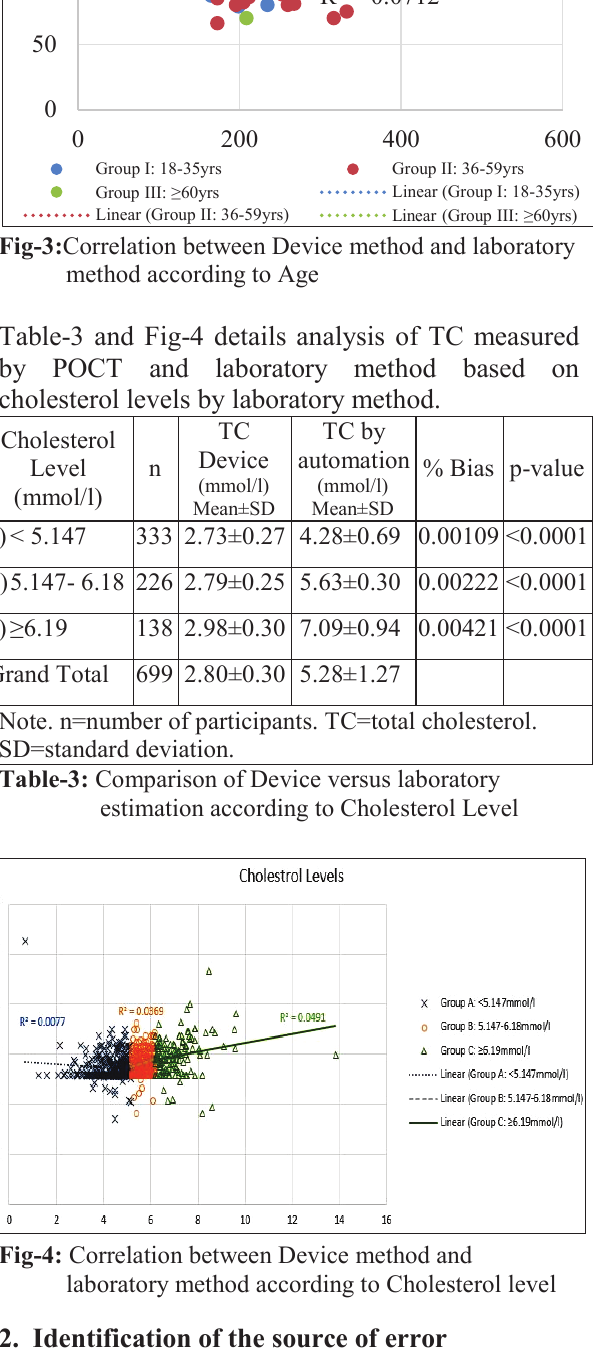
Table-2: Total Cholesterol by device versus laboratory estimation according to age groups